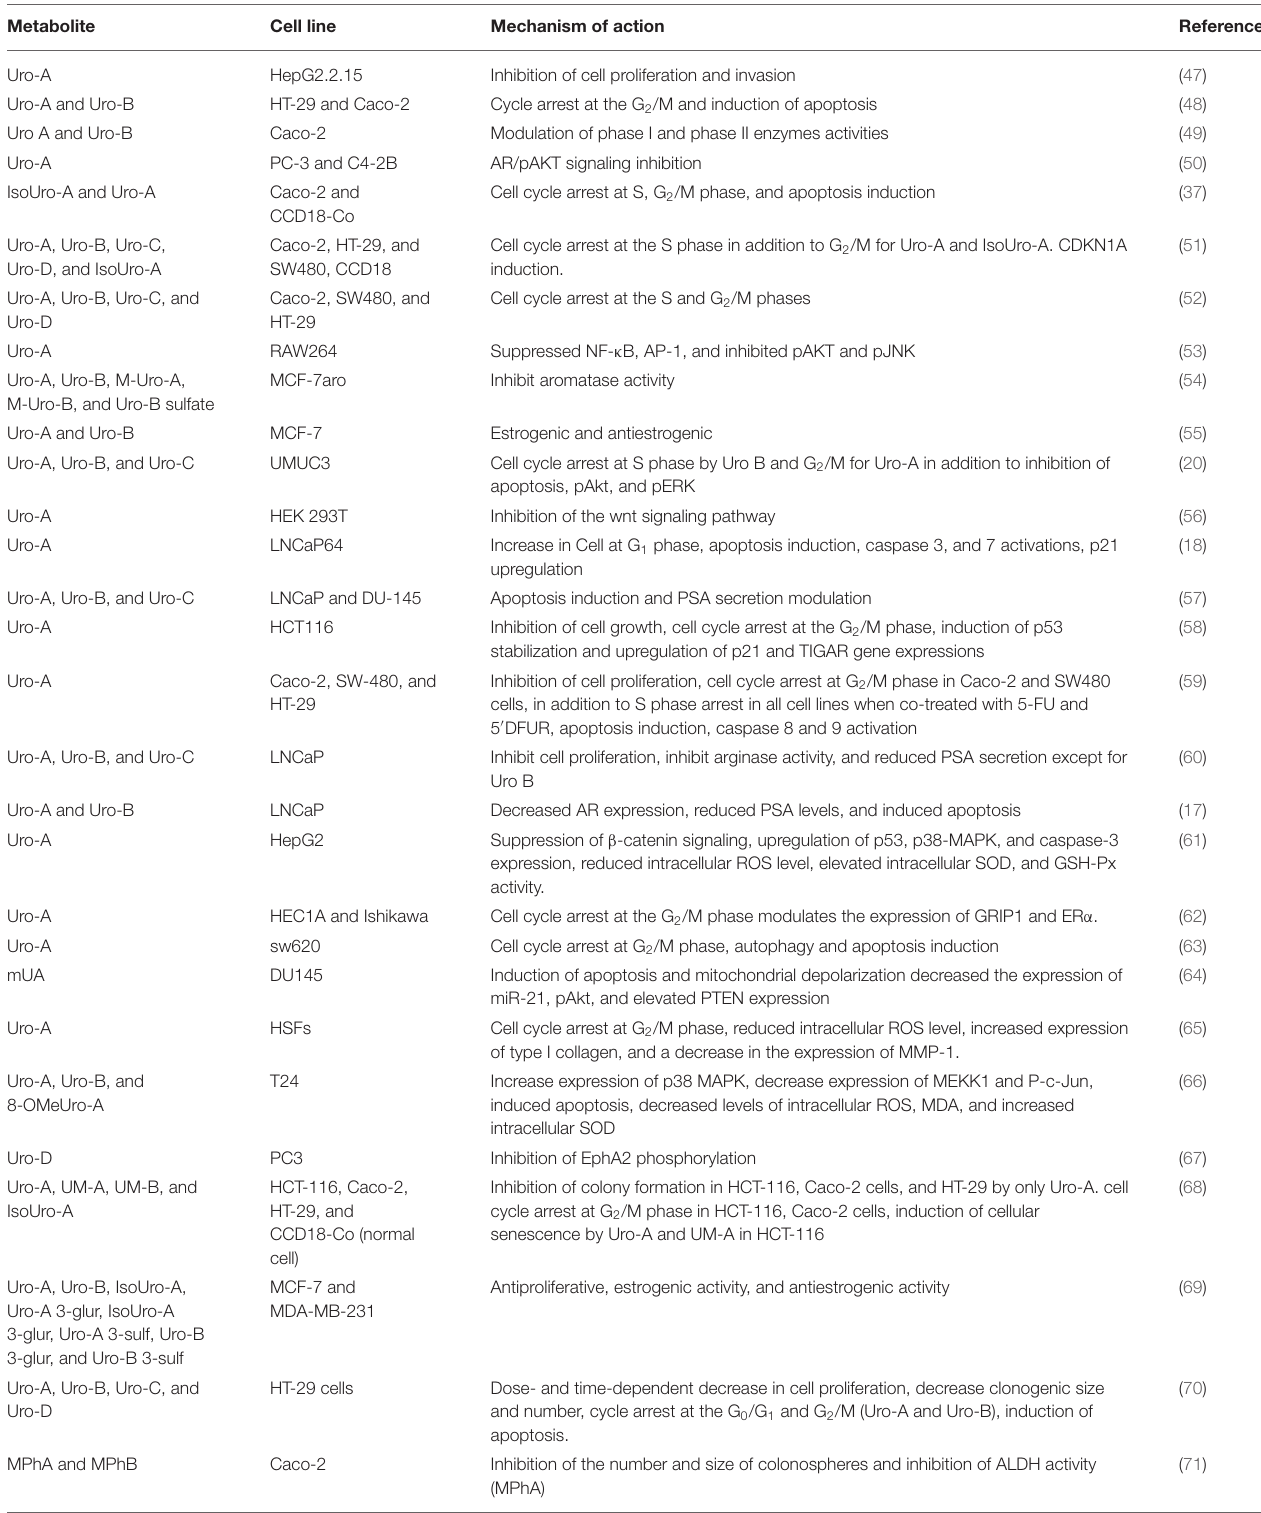
TABLE 1 | In vitro mechanism of action of